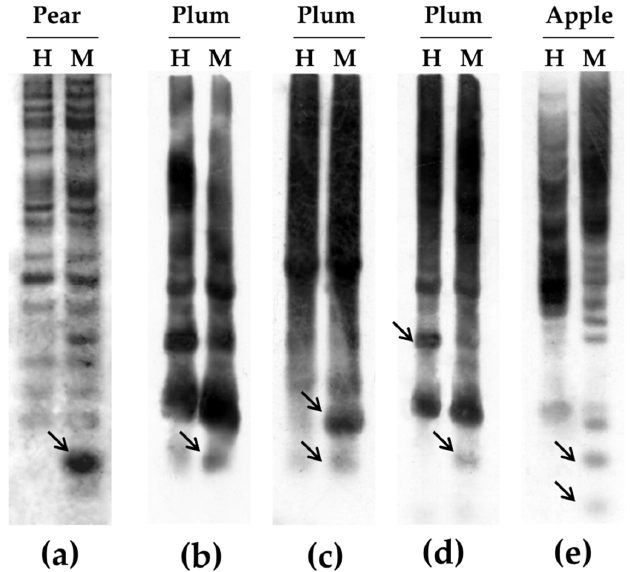
Figure 3. Gel blotting analysis of DNA methylation at the 5′CCGG sites detected by MSAP in the three fruit tree cultivars. Each DNA sample was digested with Hpa II (H) and Msp I (M), and the two digests were loaded on the gel side by side. The arrows indicate hybridization fragments that are discordant between the digests by the pair of isoschizomers, Hpa II and Msp I, and hence indicating differential DNA methylation between the inner and outer cytosines at the 5′-CCGG sites. The probes used for this experiment are sequenced MSAP fragments that are transposable elements (TEs): MSAP39 ( a ), MSAP2 ( b ), MSAP3 ( c ), MSAP76 ( d ) and MSAP61 ( e ). The detailed information of these fragments is given in Table S2.